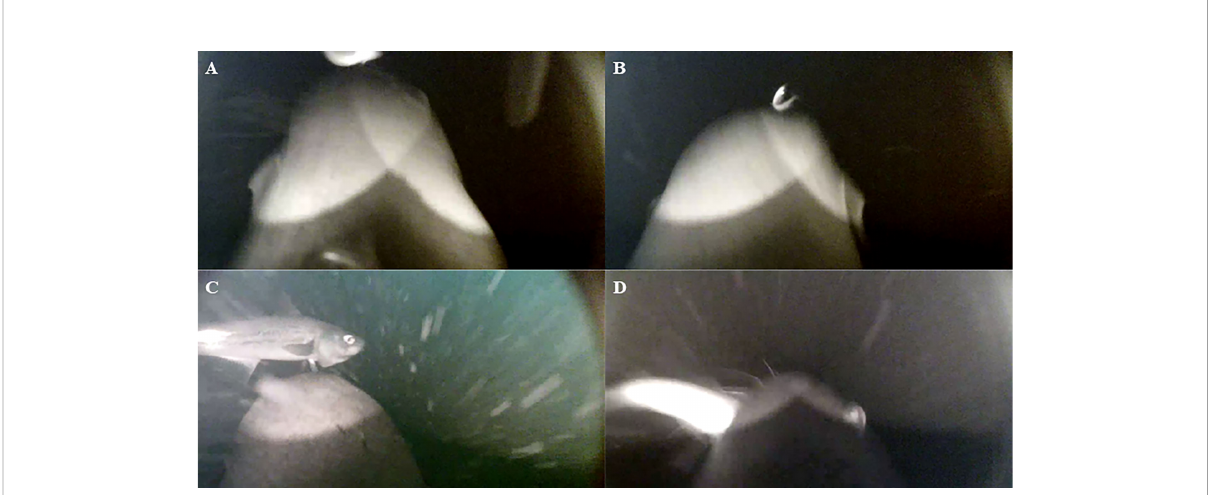
FIGURE 2 Still images collected from video fi les recorded from cameras mounted on northern fur seals. Cameras were placed in the upper back/shoulder region, so the fur seal ’ s head is visible. Images show examples of small prey prior to capture (A, B) , and large prey prior to capture (C) and during handing (D) . Illumination from the two IR LEDs is visible in night images (A, B, D) and at depth (C)